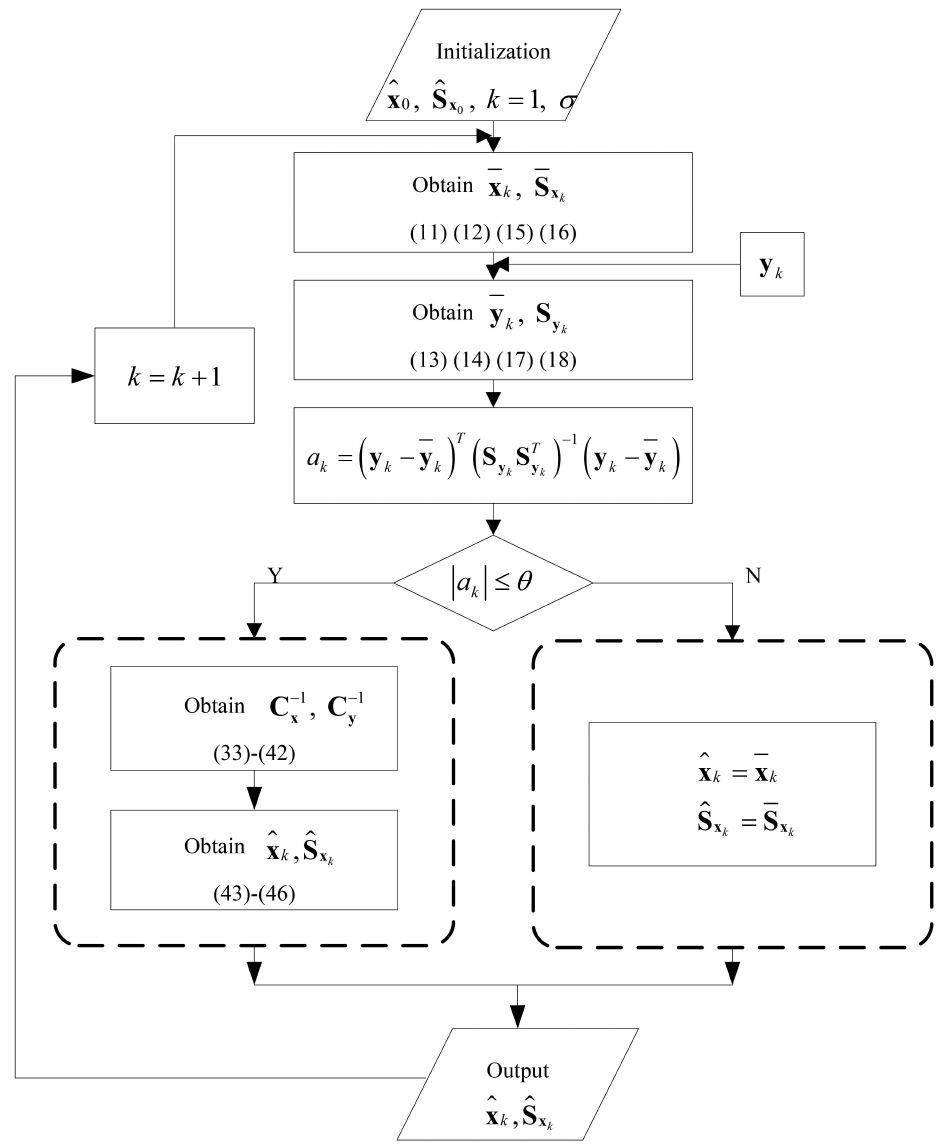
Figure 1. The flow of the CDD1 filter